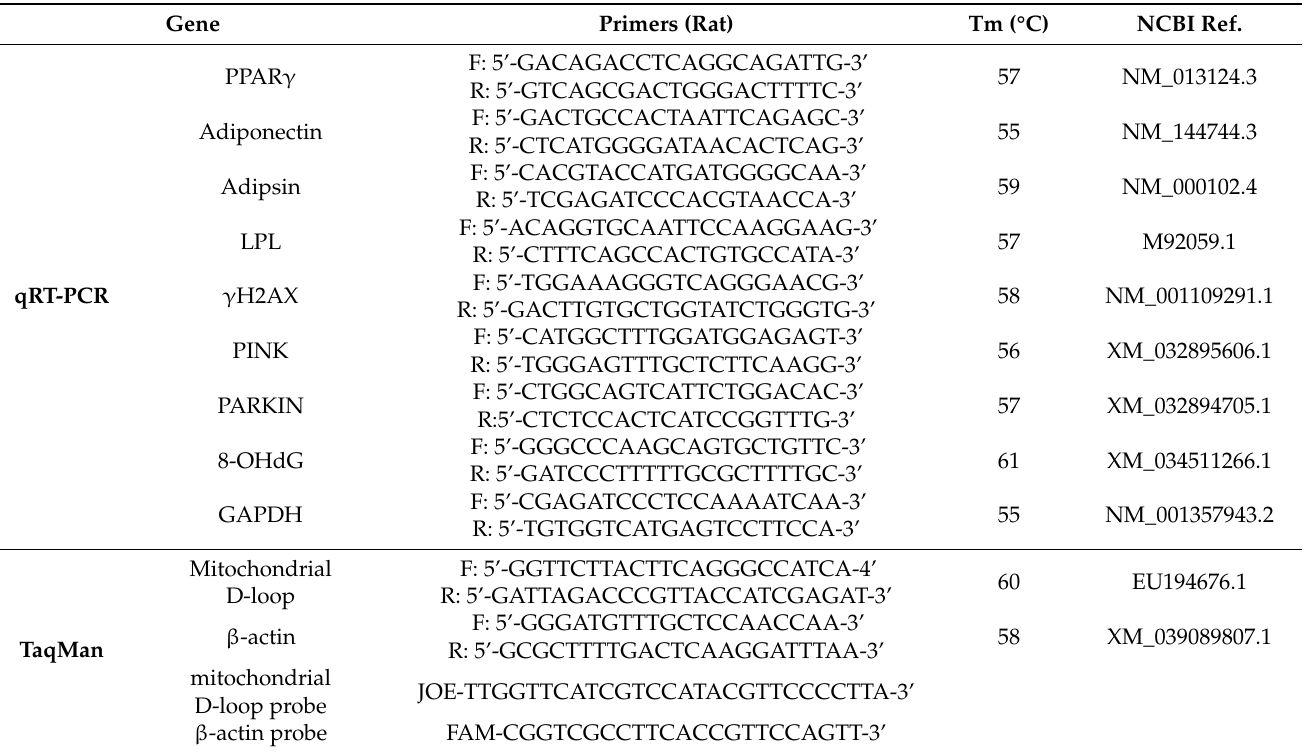
Table 1. List of primers used for qRT—PCR